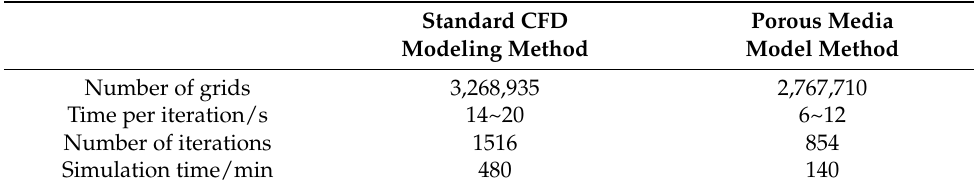
Table 5. Simulation cost